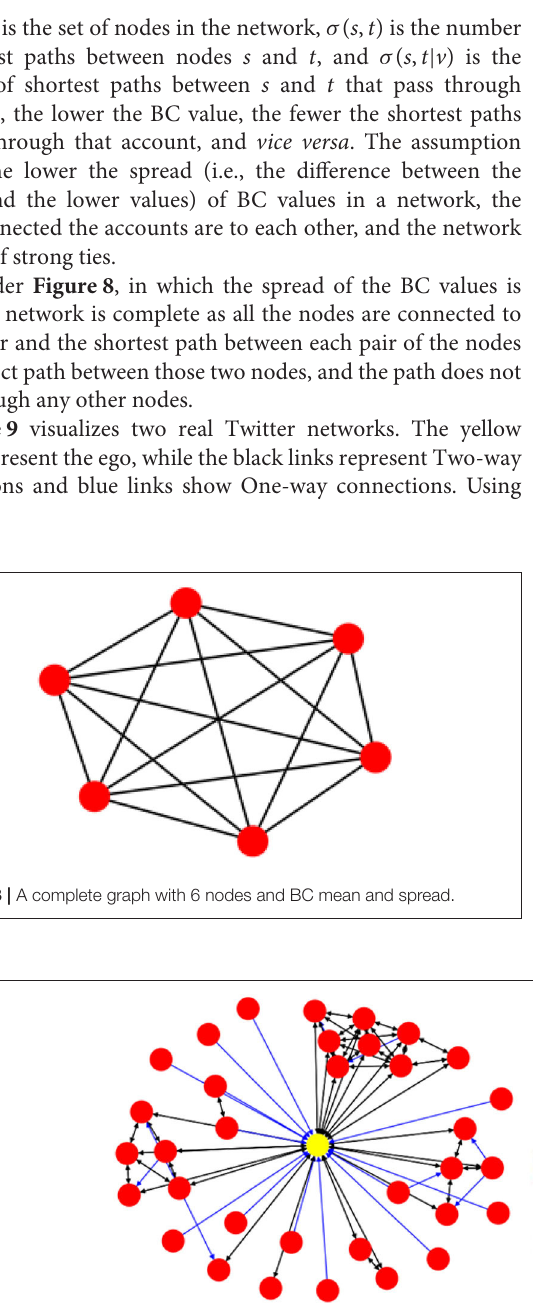
FIGURE 9 | A weak-tie ego network ( Left ) and a strong-tie network ( Right ).